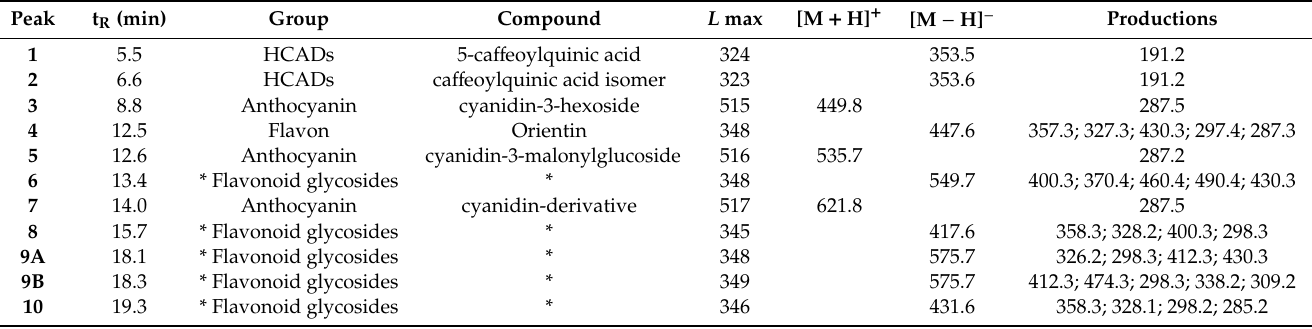
Table 1. Identification of phenolic compounds from Imperata cylindrica shoots by HPLC-DAD-ESI-MS / MS after 21 days of growth.